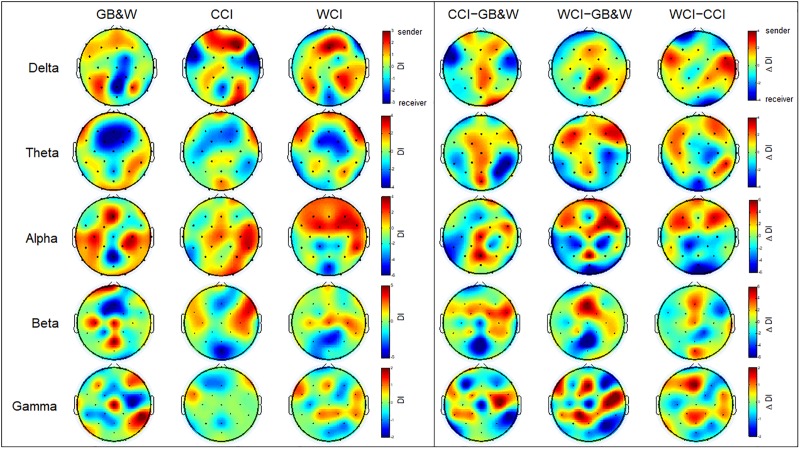
Directionality index (DI). (left) Learning condition for all three groups (GB&W, CCI, WCI) and frequencies (delta, theta, alpha, beta, and gamma), and (right) Differences between groups for each frequency band. Red colors represent sender nodes; Blue colors represent receiver nodes.